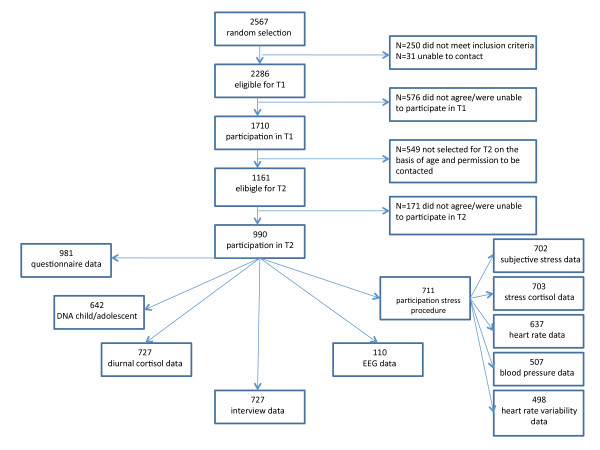
Flow chart of participation of thenormal risk(NR) population